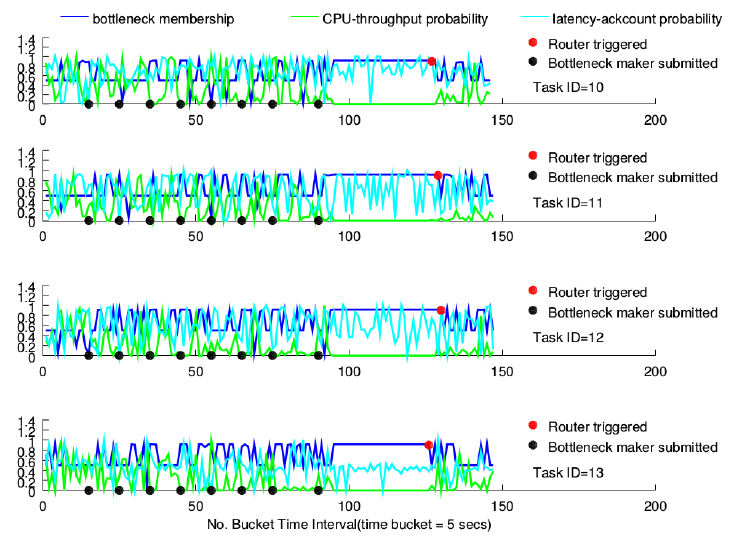
Figure 11. Router performance under the I/O-intensive bottleneck